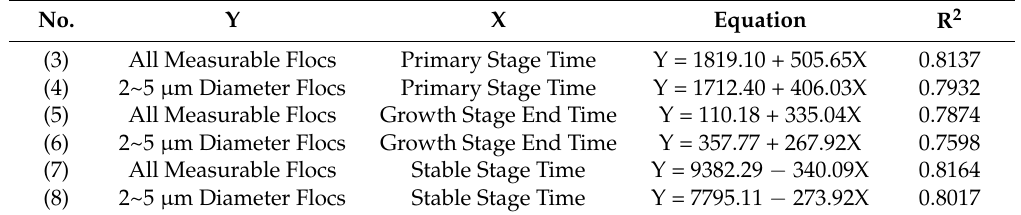
Table 2. Linear fitting equations for the particle number in settled water as a function of stage duration.